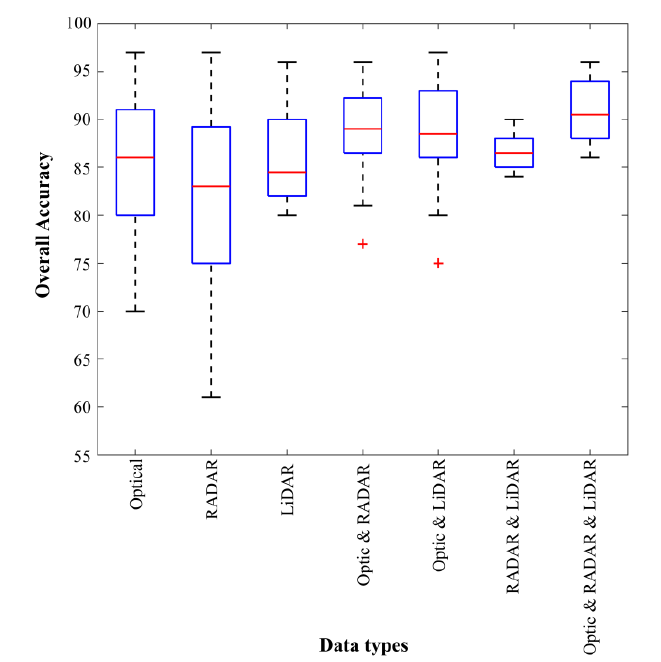
Figure 13. Overall accuracy of various data types.